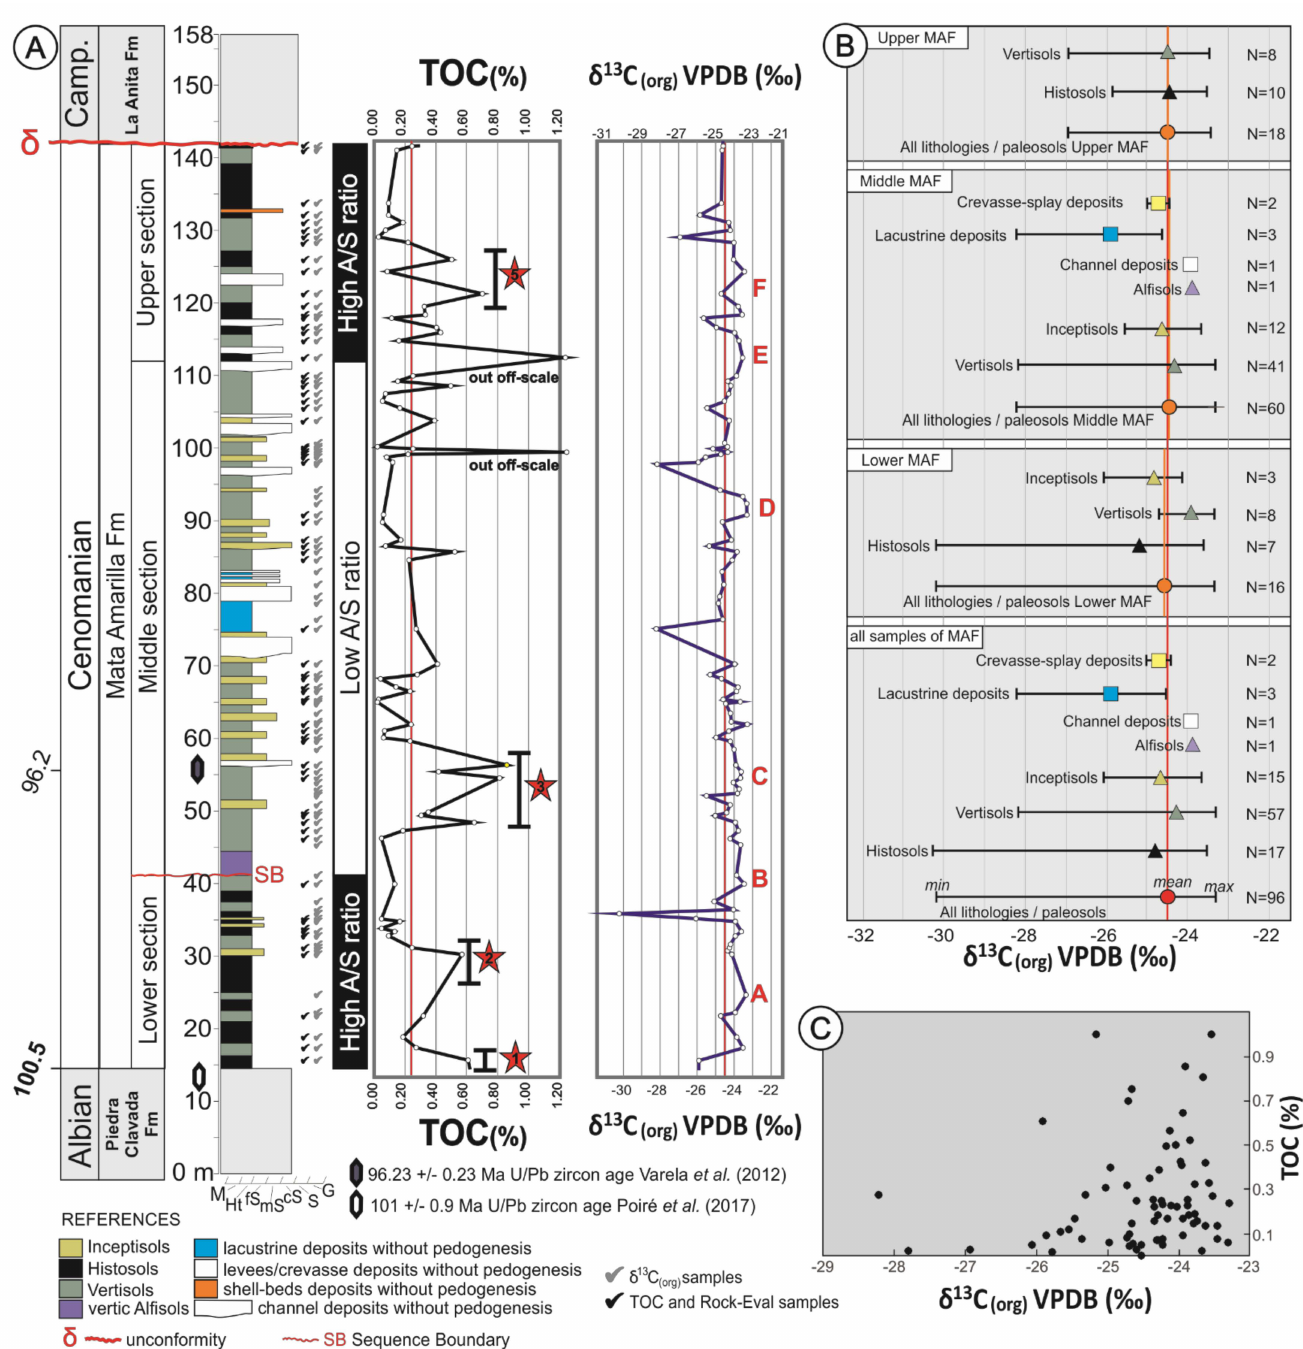
Figure 2. ( A ) Schematic sedimentary log of the Mata Amarilla Formation at Cerro Waring, showing the sedimentary facies and paleosol − types vertical distribution. Stratigraphic U/Pb zircon ages from Varela et al. (2012a) and Poir é et al. (2017). TOC content and δ 13 C org composition of the Mata Amarilla Formation are shown with red lines representing the average values of TOC and δ 13 C org , respectively. Red stars indicate peaks or intervals characterized by increased TOC. Positive shifts δ 13 C org were labeled with the capital letters from “A” to “F”. ( B ) Mean, maximum and minimum δ 13 C org values for the different lithostratigraphic intervals of the Mata Amarilla Formation. ( C ) XY-plot of δ 13 C org versus TOC values illustrating the lack of